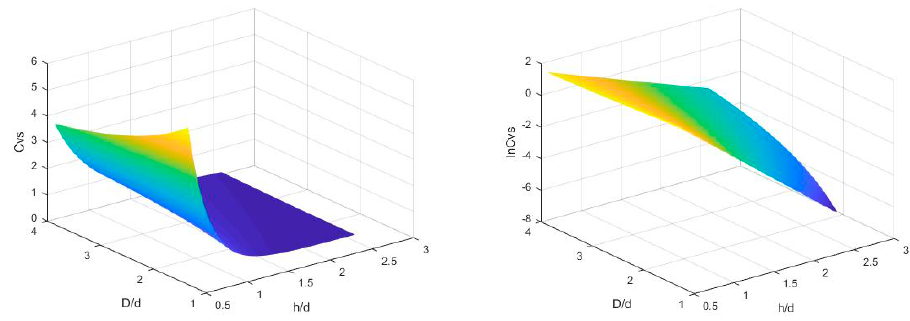
Table 6. Exponential fitting relations between parameters and D / d.